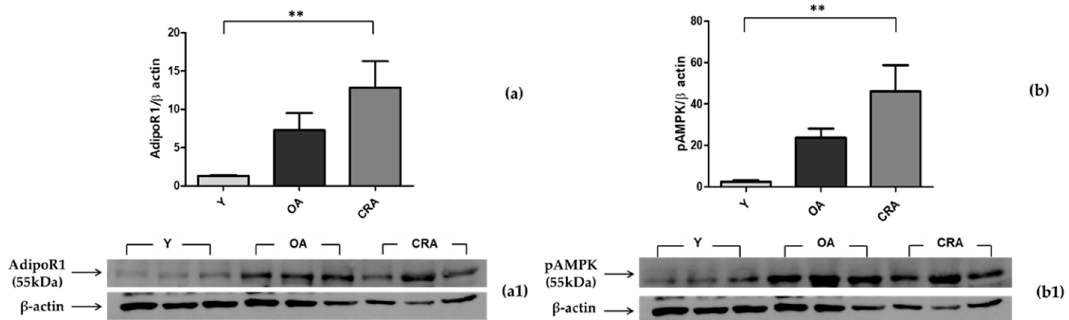
Figure 3. Western blotting of AdipoR1 ( a ) and AMPK activation (pAMPK) ( b ) in adipose tissue samples of Y, OA, and CRA rats; ( a1 , b1 ) show the densitometric quantification of the blots. Protein loading was verified by using the anti- β -actin antibody. Data are means ± SE of five determinations for each animal ( n = 6). Statistical differences were evaluated by one-way ANOVA, followed by Bonferroni’s multiple comparison test (** p < 0.001).